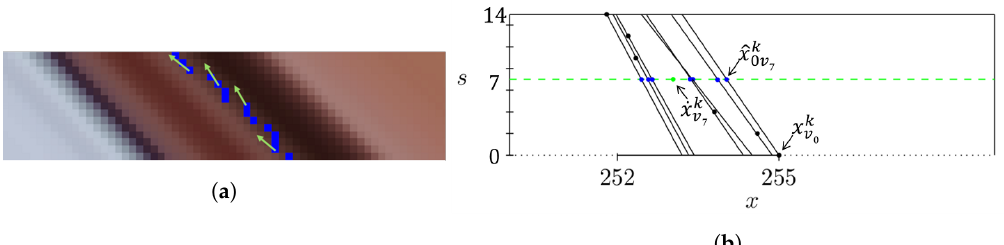
Figure 7. Coordinates correction: in ( a ), the scattered line produced by an estimated landmark point over the horizontal views; in ( b ), magnified view of the level lines computed using structure